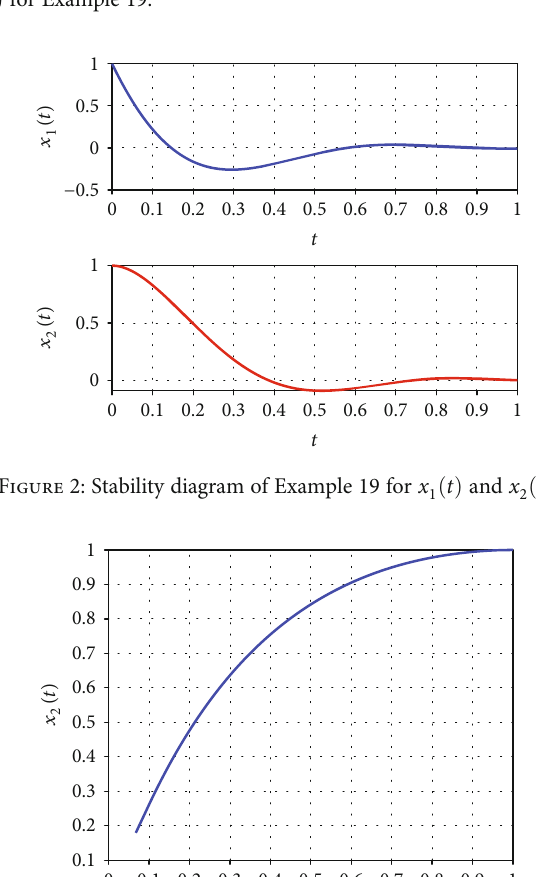
1 ð t Þ and x 2 ð t Þ